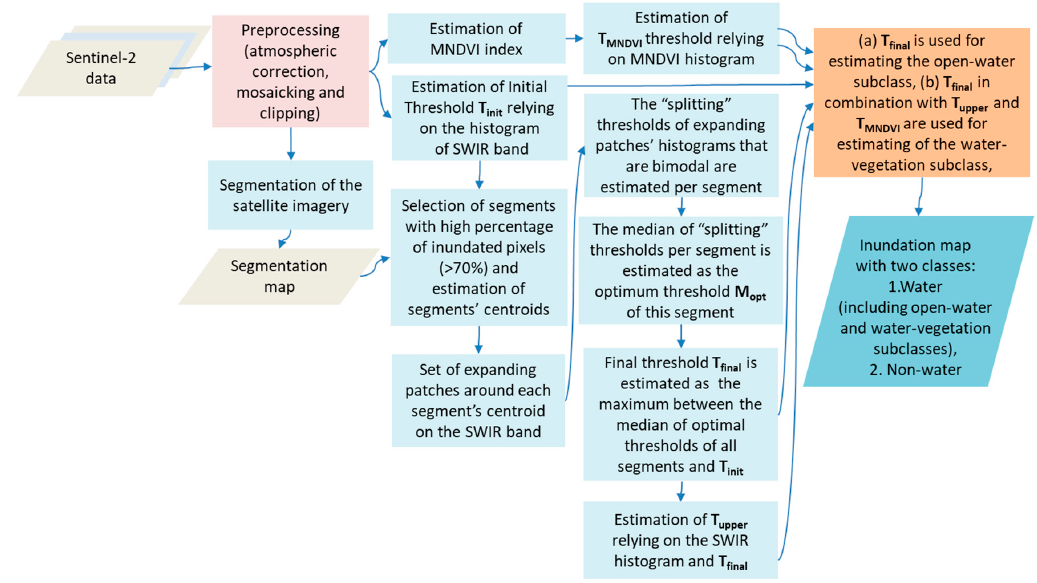
2. Figure 2. Schematic flow diagram of the proposed unsupervised approach (MNDVI, Modified Normalized Vegetation Index; SWIR, Short-Wave